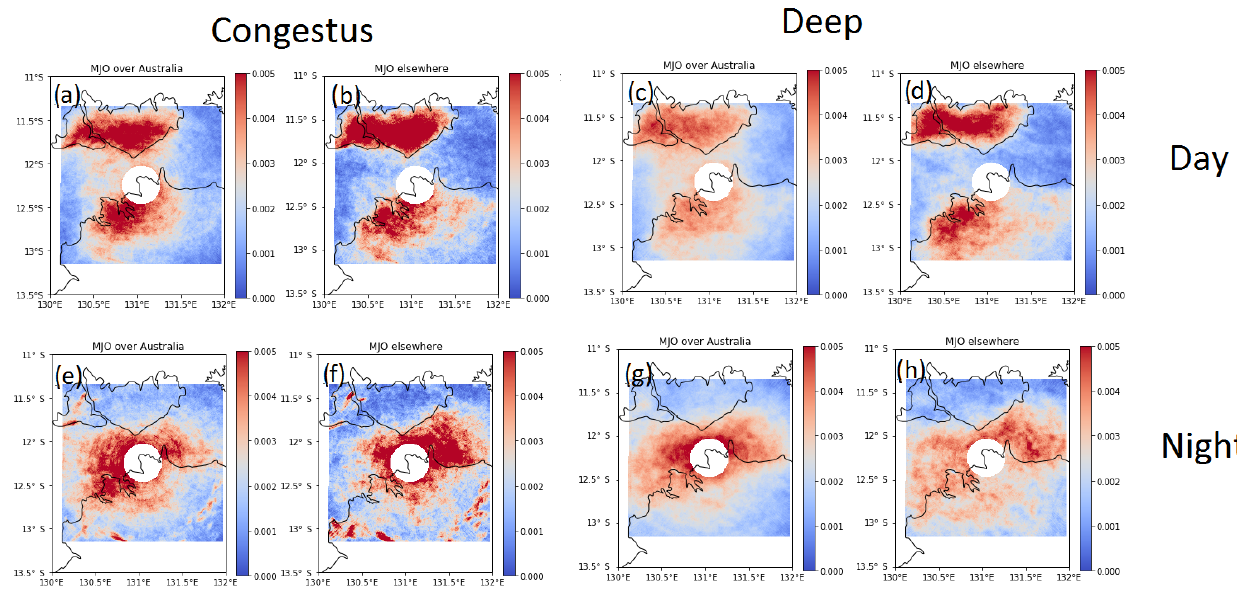
Figure 10. The normalized frequency of occurrence of ETHs < 7km in MJO active (a) and (b) MJO inactive conditions during the day (06:00 to 19:00LT). (c, d) as in (a, b) , but for ETHs > 7km. (e, f) as in (a, b) , but at night (19:00 to 06:00LT). (g, h) as in (e, f) , but